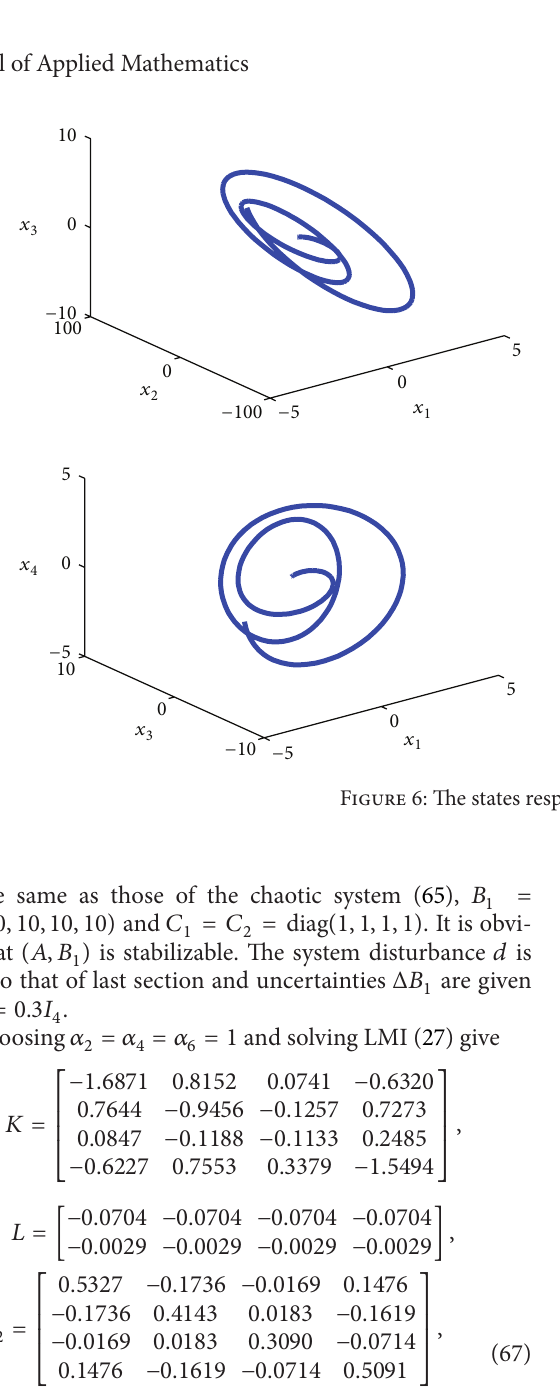
Figure 7: The disturbance 𝑑 and the approximation output of